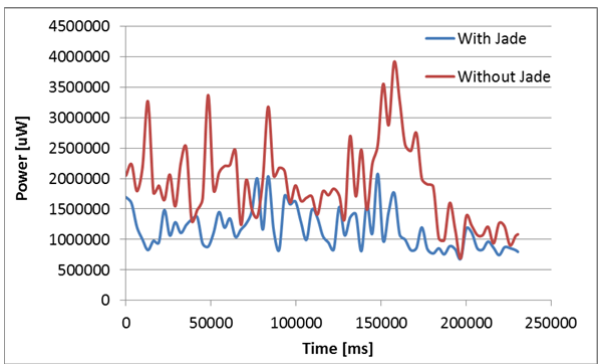
Figure 6: Power consumption of FaceDetection